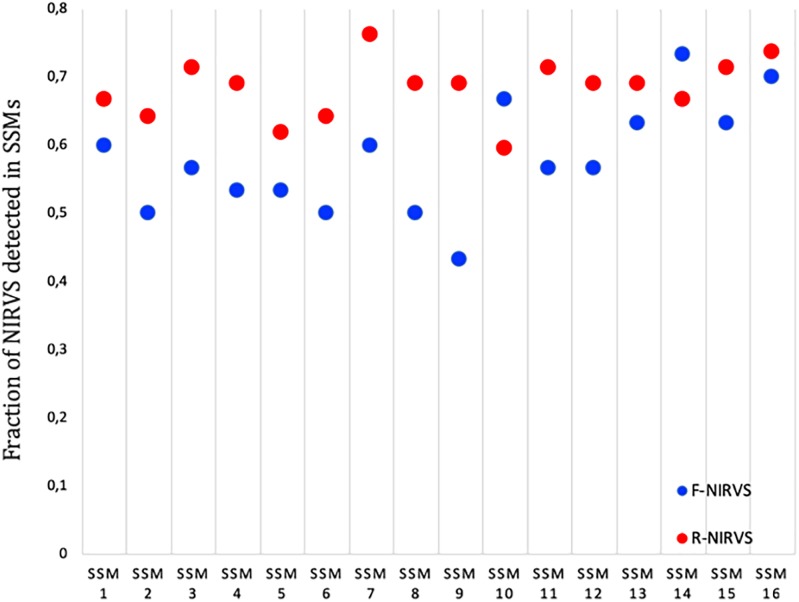
Prevalence of R-NIRVS (red) and F-NIRVS (blue) in each SSMs. Prevalence was calculated in each sample as the ration between detected NIRVS and annotated NIRVS for both R- and F-NIRVS.